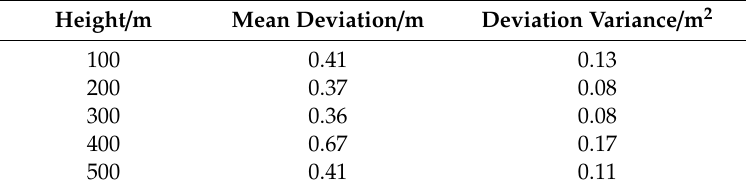
Figure 5. The bar diagram of positioning error. Table 2. The aircraft positioning error.